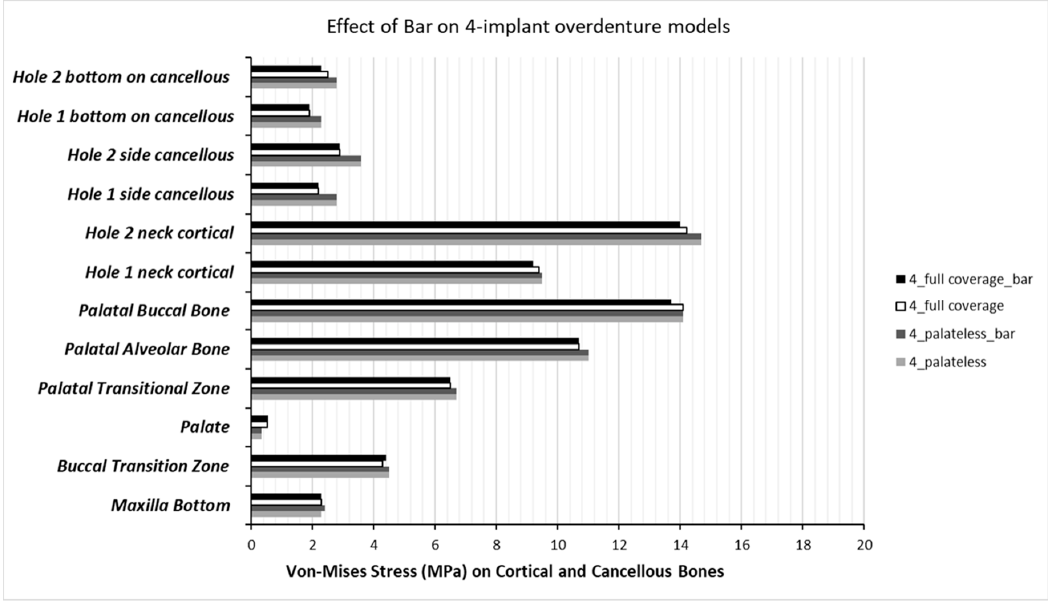
Figure 7. Effect of bar on four-implant overdenture models with axial loading. Figure 7. E ff ect of bar on four-implant overdenture models with axial